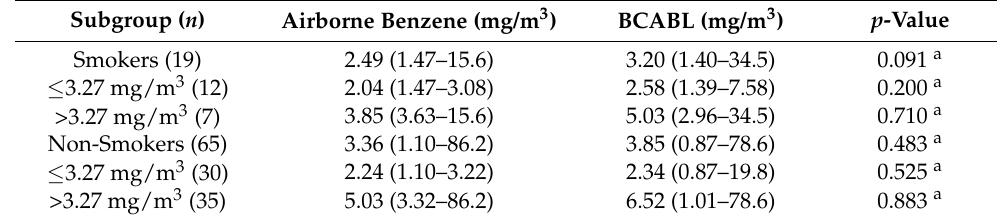
Table 4. Summary of airborne benzene and BCABL based on t, t -MA in smokers and non-smokers. Subgroup ( n )